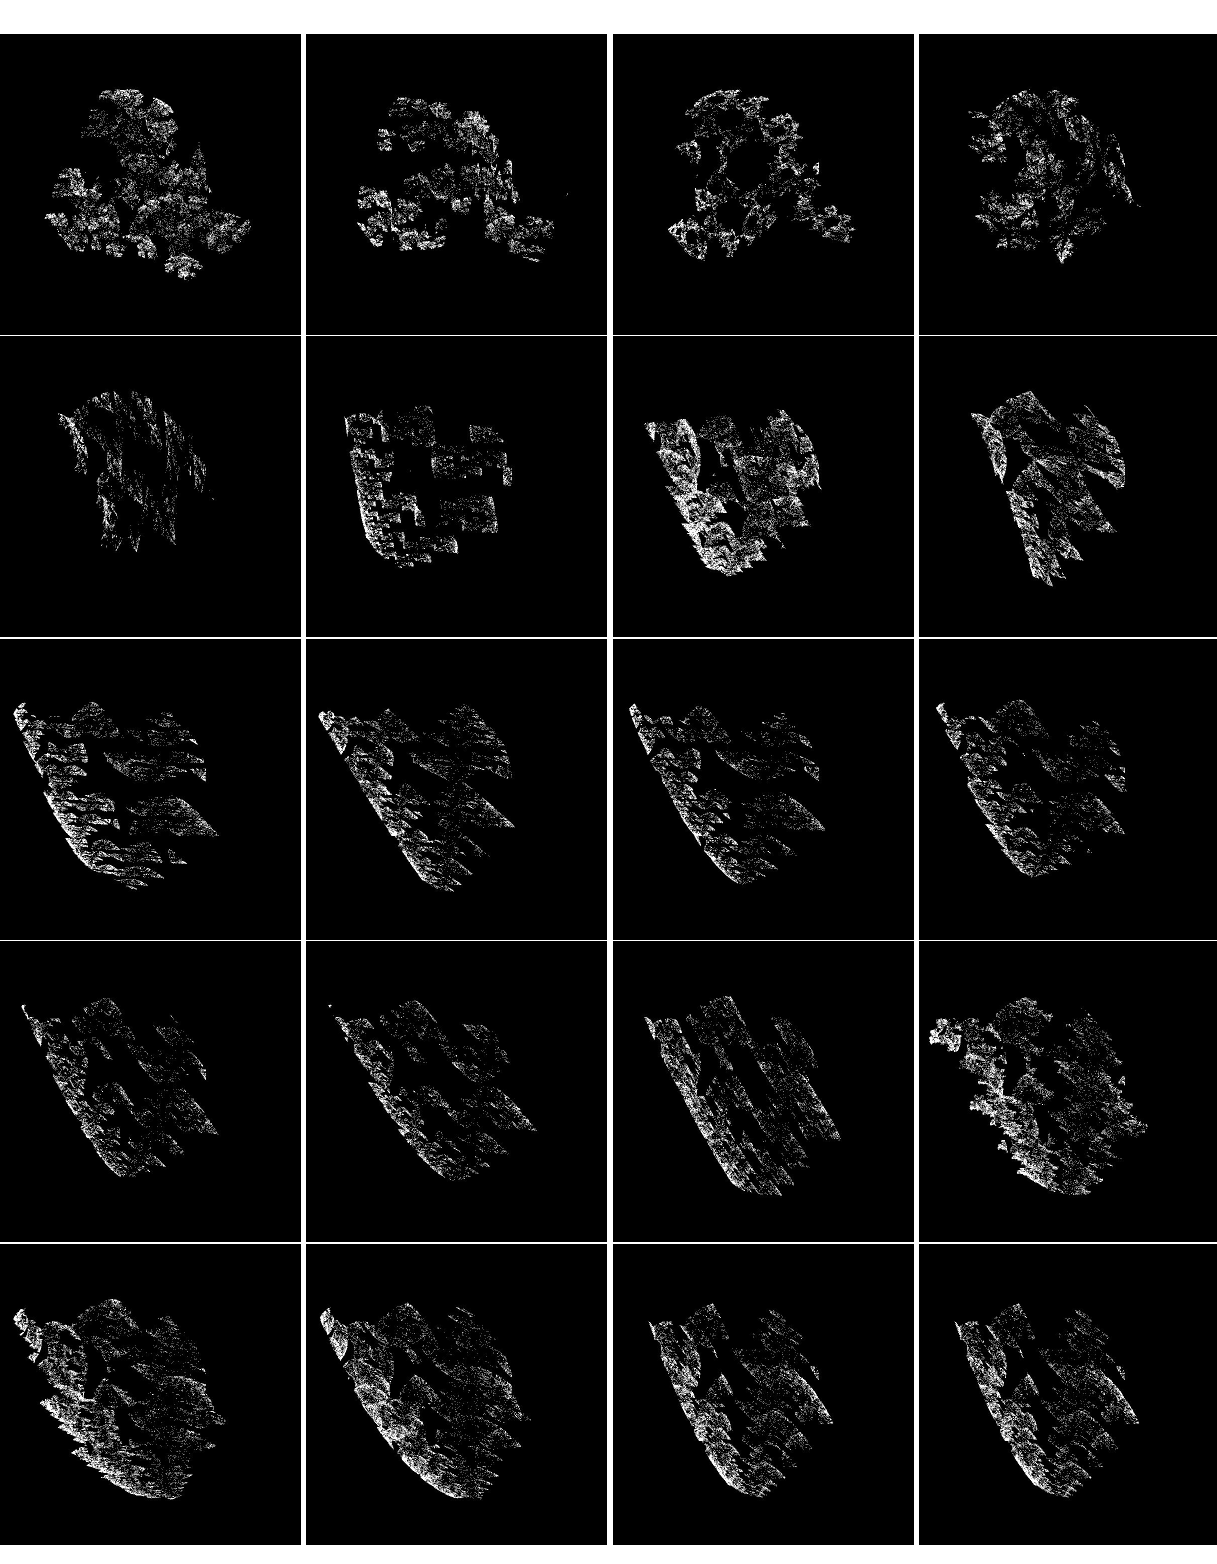
Figure 7. ( left – right , top – bottom ): Evolution of the intersection between the original and the recon- structed images for 0–380 iterations (step size, 20